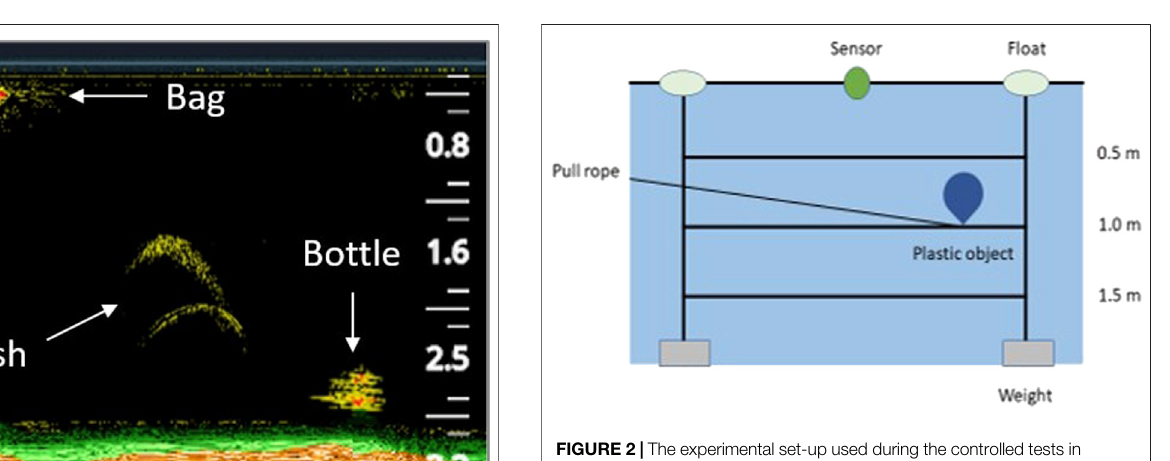
FIGURE 2 | The experimental set-up used during the controlled tests in the swimming